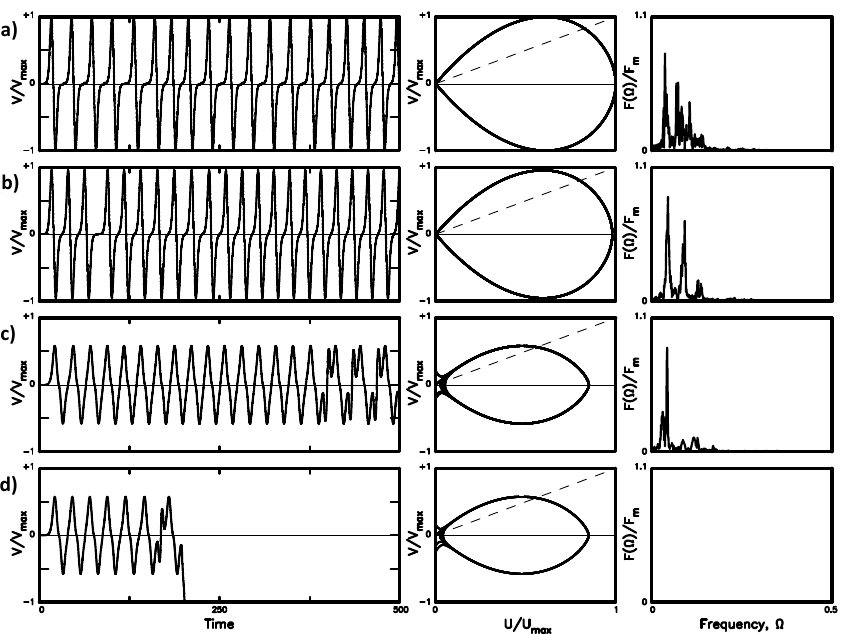
Figure 8. The time variation in V/V max , the phase portrait of V/V max versus U/U max , and the power spectrum for four values of η : (a) for η = 0 . 43; (b) for η = 0 . 47; (c) for η = 0 . 98; and (d) for η = 0 . 99 when U c = 055 for the TP law of F(U) = exp ( − U/U c )